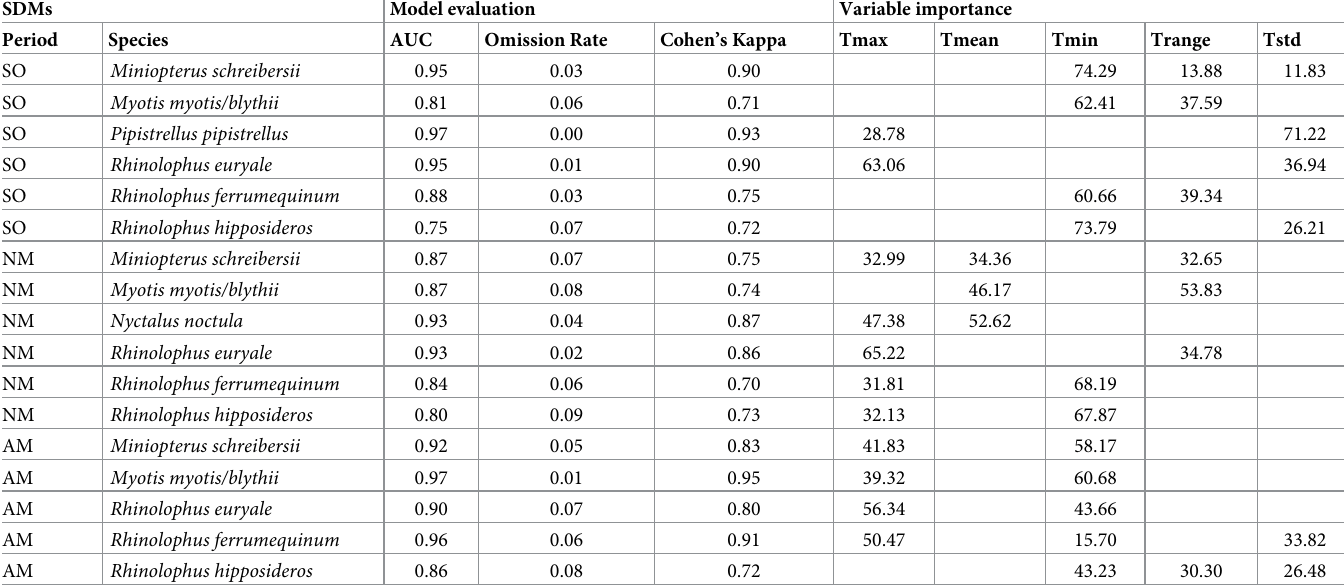
Table 5. SDM results per species—ensemble model evaluation and variable importance